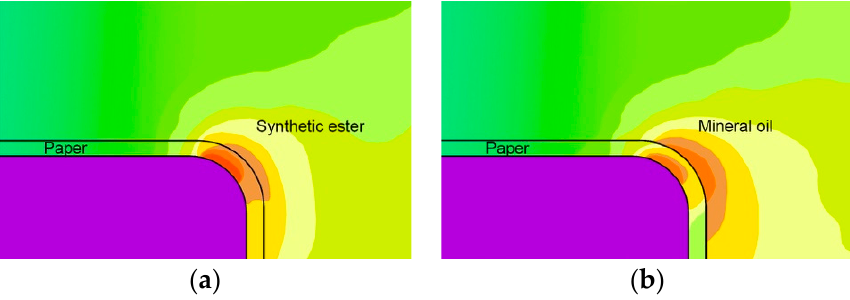
Figure 2. Electric field distribution in transformer insulation: ( a ) synthetic ester; ( b ) mineral oil.